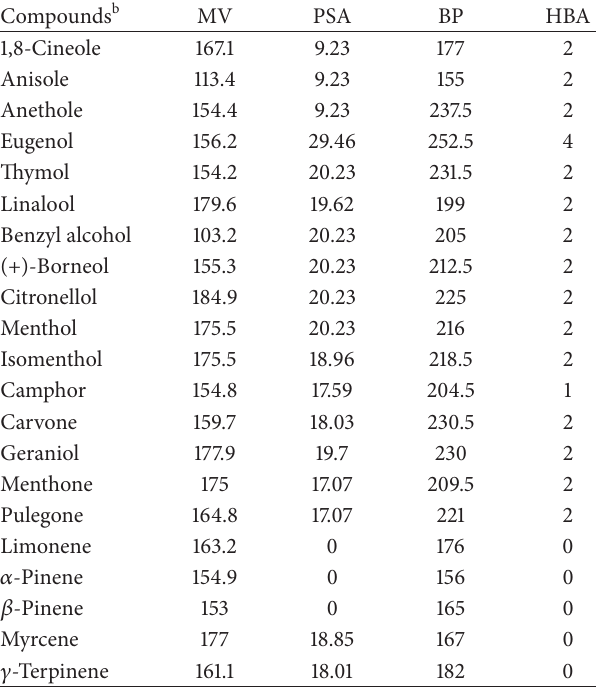
Table 1: Calculated molecular descriptors a for terpene and phenyl- propene compounds used in QSAR analysis of the fumigant activity against head